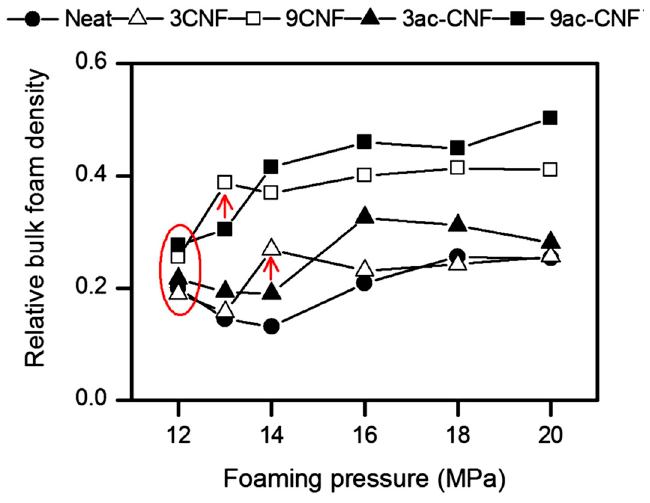
Figure 13. Variations of the relative bulk foam density of PLA foams as functions of foaming pressure. Arrows indicate the foaming pressure at which the relative bulk foam density increases suddenly for the CNFs composites. Reprinted from Dlouhá et al. [126]. Permission conveyed through Copyright Clearance Center, Inc.